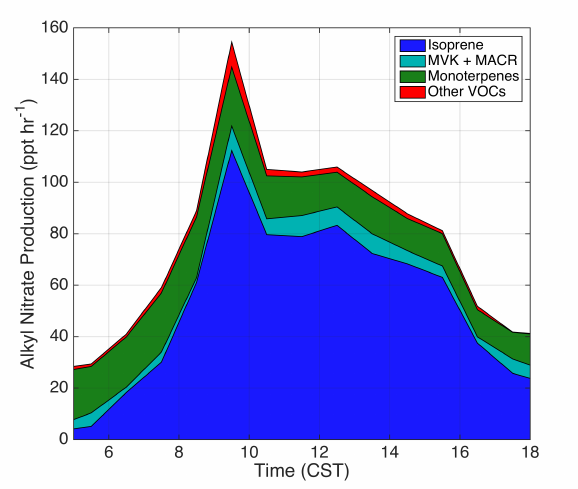
Figure 5. Average daytime production of (cid:54) ANs, categorized based on VOC precursors.